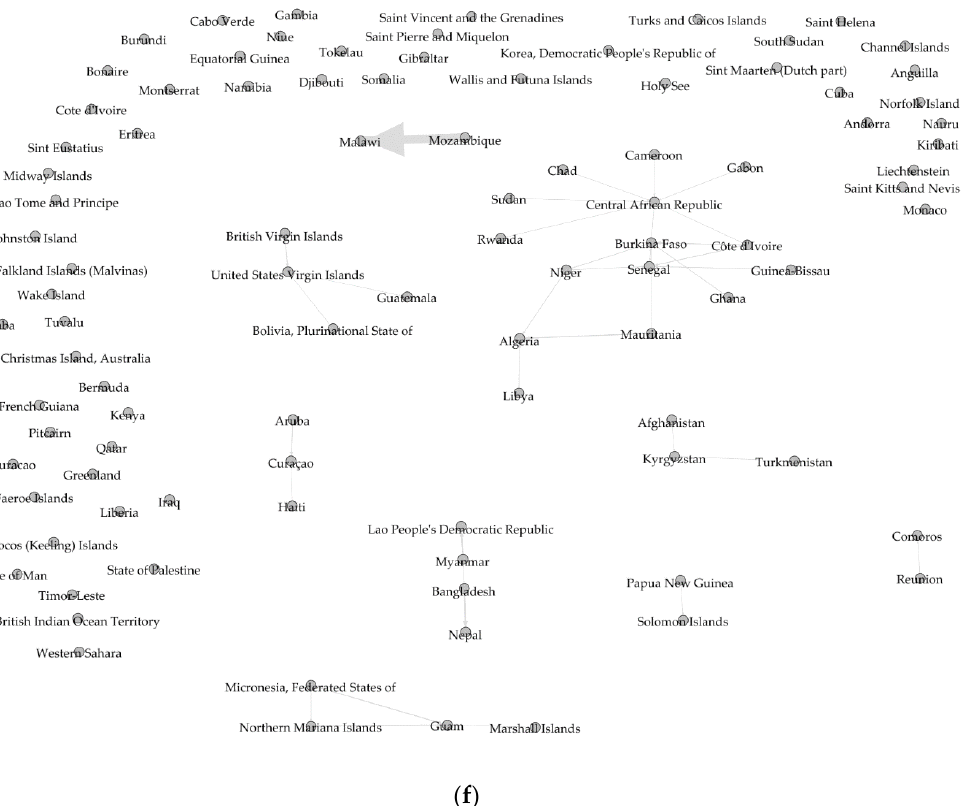
Figure A2. Simulation of removal of top nodes ranked by betweenness centrality. ( a ) Top 10% nodes removed, ( b ) top 20% nodes removed; ( c ) top 30% nodes removed, ( d ) top 40% nodes removed, ( e ) top 50% nodes removed, and ( f ) top 60% nodes removed. Source: authors.